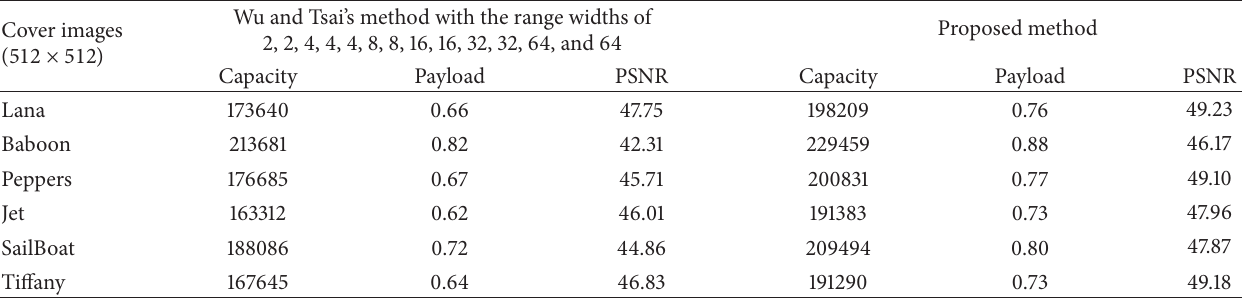
Table 4: Comparison between Wu and Tsai’s method and the proposed method by theoretical analysis. Cover images (512 ×